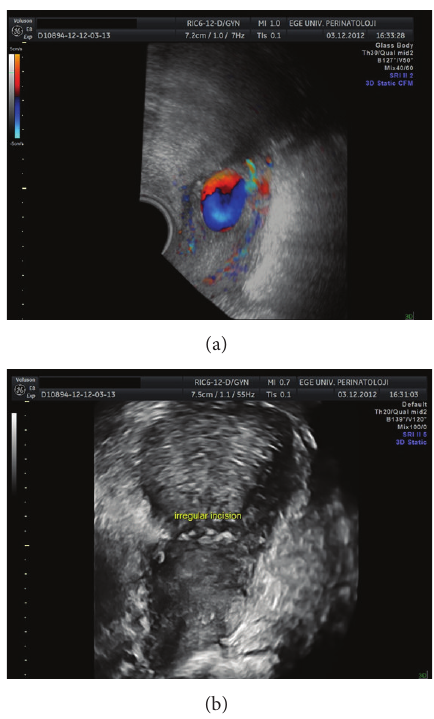
Figure 3: Three-dimensional (3D) sonography or 3D power Dop- pler mode showed the same cystic mass with a suspicion of irregular incisional track and the highly vascularized cystic mass anastomo- sed to the uterine vessels.